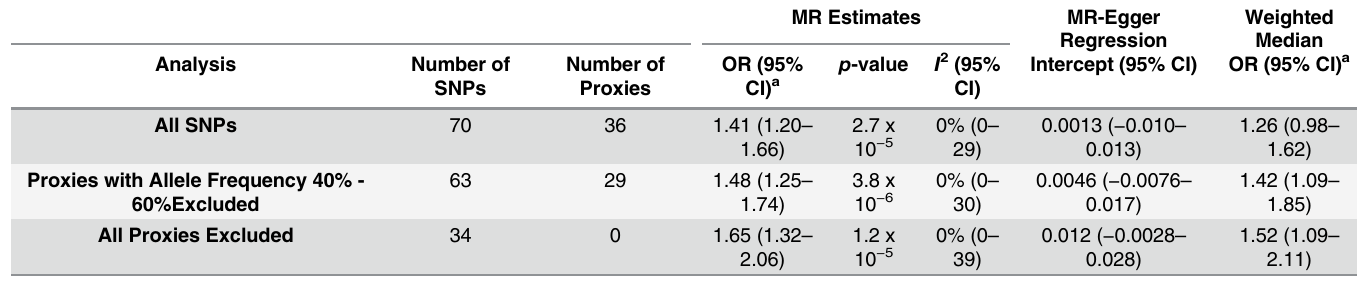
Table 2. Results of MR analyses and sensitivity